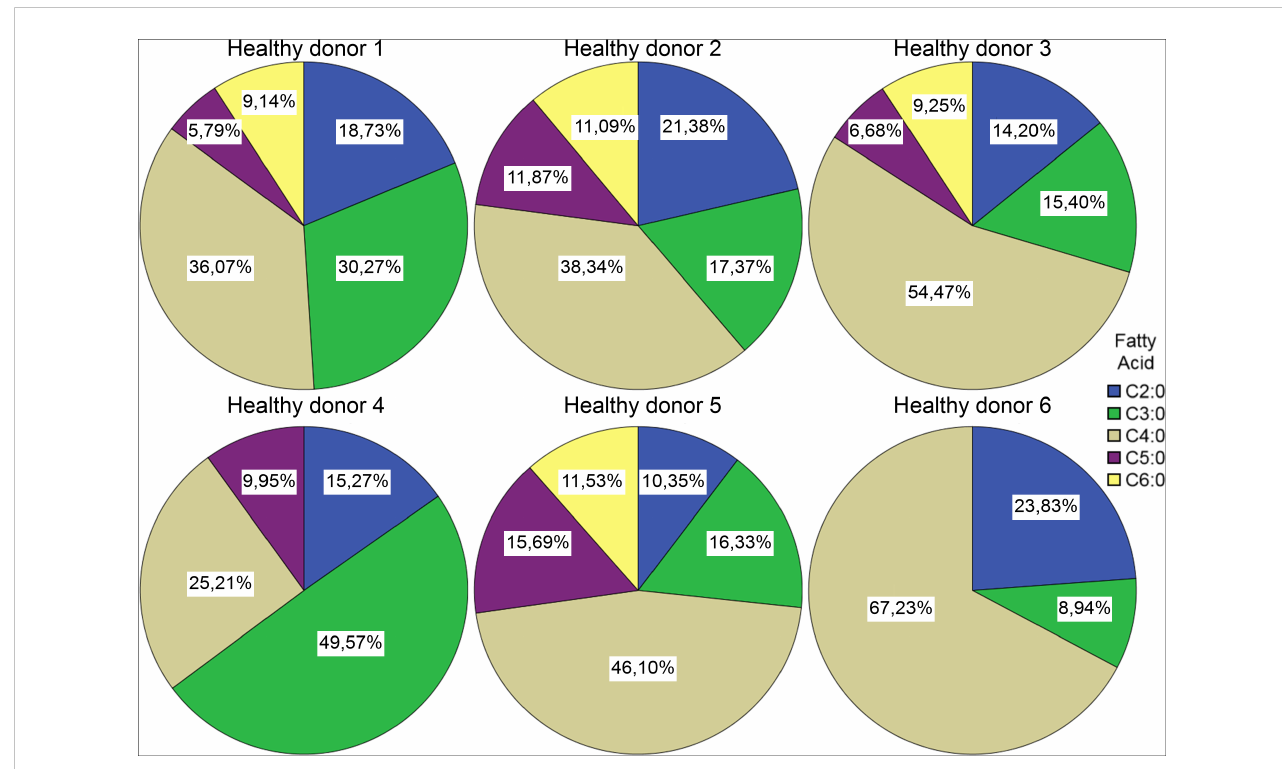
FIGURE 5 Short chain fatty acid compositions in samples from healthy donors. Comparing the compositions of pre- and post-lyophilisation samples of the FMT donor, it seems that the lyophilisation altered the relative abundances of the SCFAs: the ratio of the C4:0 component decreased, while the ratio of C2:0 increased (Figure